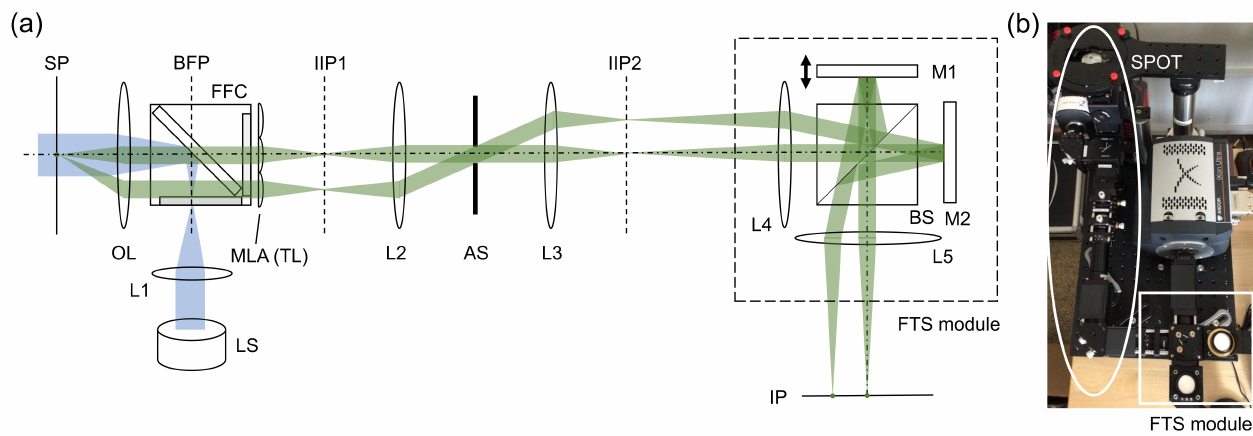
Figure 1. Snapshot projection optical tomography (SPOT) system combined with Fourier-transform spectroscopy (FTS) module: ( a ) schematic diagram, and ( b ) a photograph of the combined system. LS: light source (LED); L1–L5: lenses; M1, M2: mirrors, OL: objective lens; MLA: micro-lens array; TL: tube lens; FFC: fluorescence filter cube; BS: beam splitter; AS: aperture stop; SP: sample plane; IIP1, IIP2: intermediate image planes; and IP: image plane. Two emission beam paths are traced from a point-like emitter at the sample plane to the image